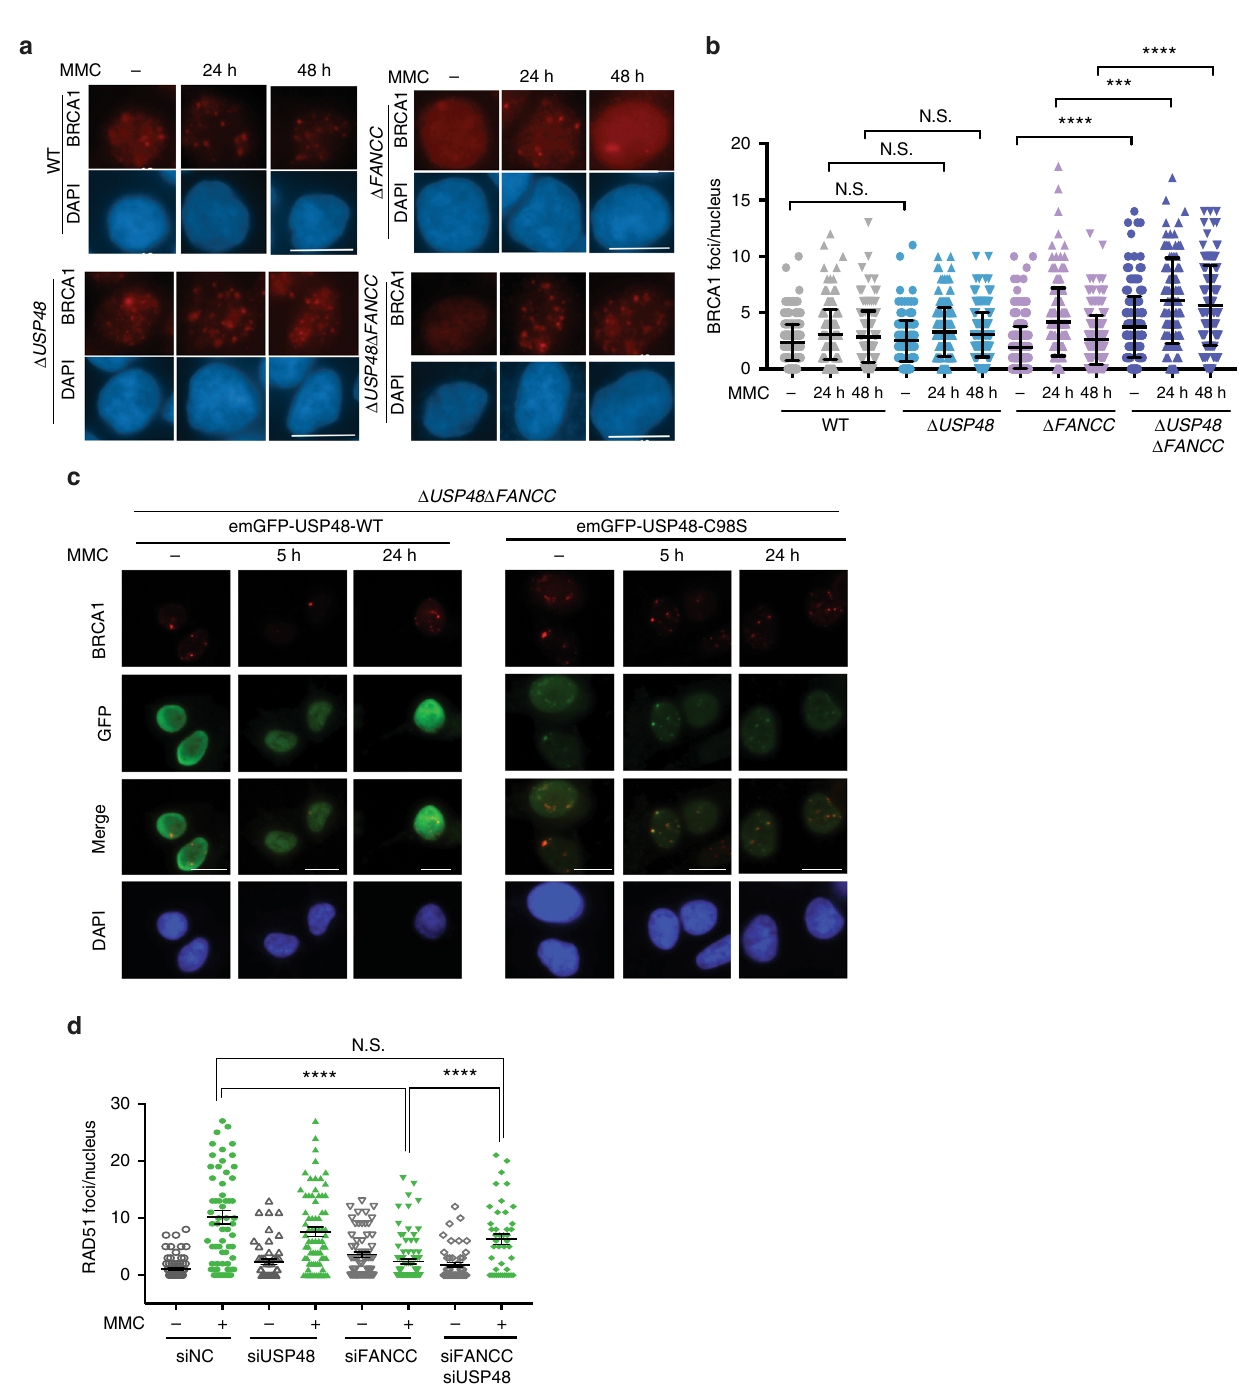
Fig. 5 FA cells lacking USP48 show enhanced recruitment of HR markers. a Representative immuno fl uorescence images of WT, Δ USP48, Δ FANCC , and Δ USP48 Δ FANCC cells after staining for BRCA1 following MMC treatment (25 nM) for the indicated times. Scale bar = 10 μ m. b Quanti fi cation of BRCA1 foci in WT, Δ USP48, Δ FANCC , and Δ USP48 Δ FANCC cells. Error bars show mean with SD (standard deviation). Statistical signi fi cance was determined using the Mann – Whitney test with p < 0.05 as a threshold. N.S. not signi fi cant; *** = p < 0.001; **** = p < 0.0001. c Immuno fl uorescence images after staining for BRCA1 and GFP on Δ USP48 Δ FANCC cells after treatment with MMC at the indicated time-points. Cells were transiently transfected with emGFP-USP48-WT and emGFP-USP48-C98S. d Quanti fi cation of RAD51 foci in WT, siUSP48 , siFANCC , and siUSP48siFANCC cells treated with MMC (100 nM) for 18 h. Quanti fi cation was performed using the ImageJ software. Error bars show mean ± S.E.M. (standard error of the mean). Statistical signi fi cance was determined using the Mann – Whitney test with p < 0.05 as a threshold. N.S. not signi fi cant; **** = p <